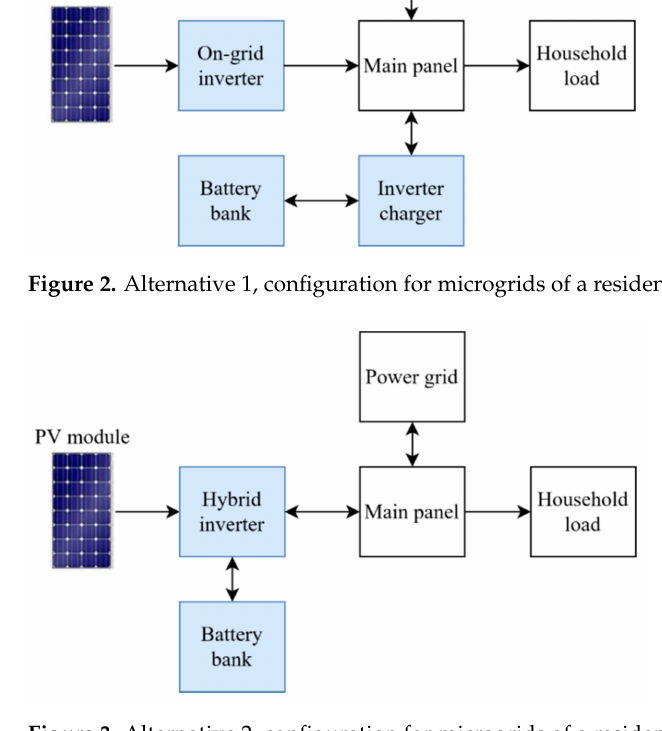
Figure 3. Alternative 2, configuration for microgrids of a residential